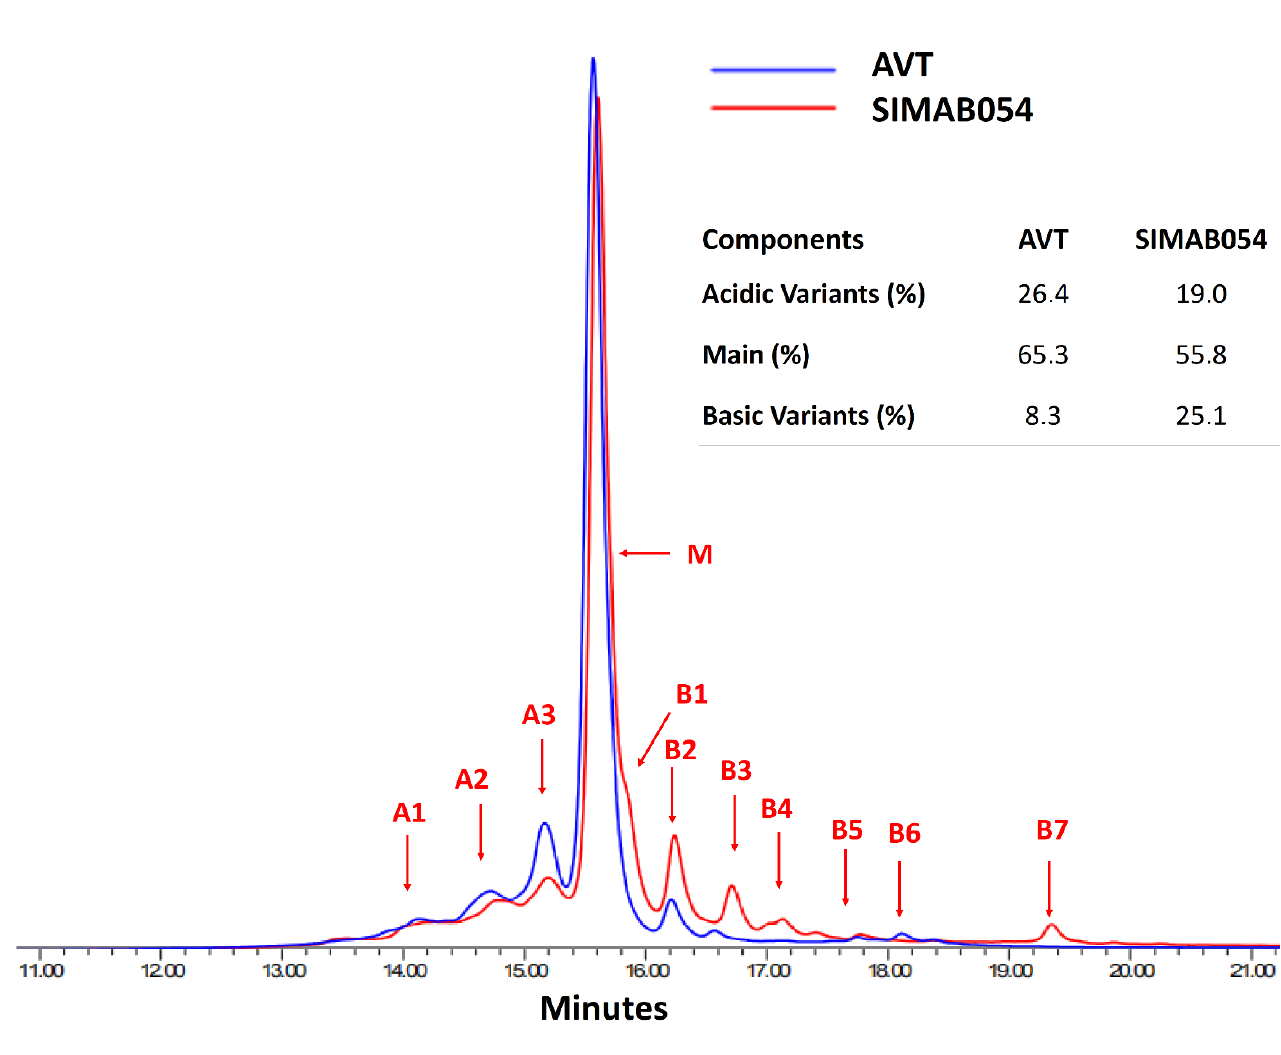
Figure 1. CEX results of AVT and SIMAB054. Overlay of CEX results of AVT and SIMAB054 and a comparative table of acidic, basic, and main charge variant percentages.